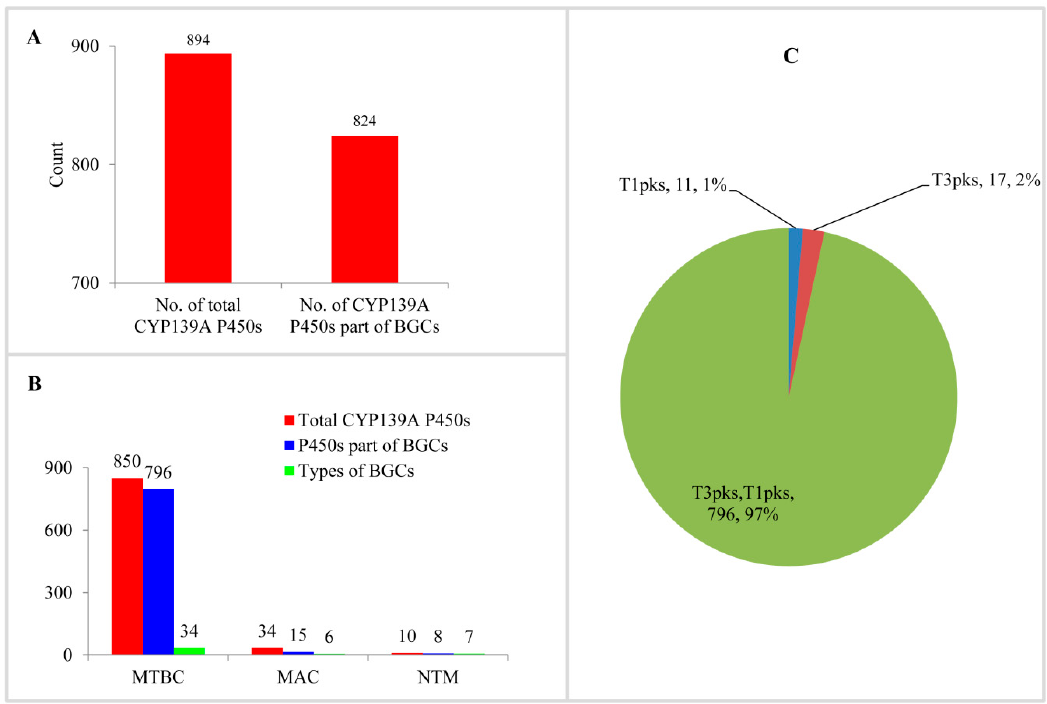
Figure 4. CYP139A P450s secondary metabolite BGCs analysis in mycobacterial species. ( A ) Analysis of CYP139A P450s that are part of BGCs. ( B ) Comparative analysis of CYP139A P450s that are part of BGCs and types of BGCs in different mycobacterial categories. Abbreviations: MTBC,